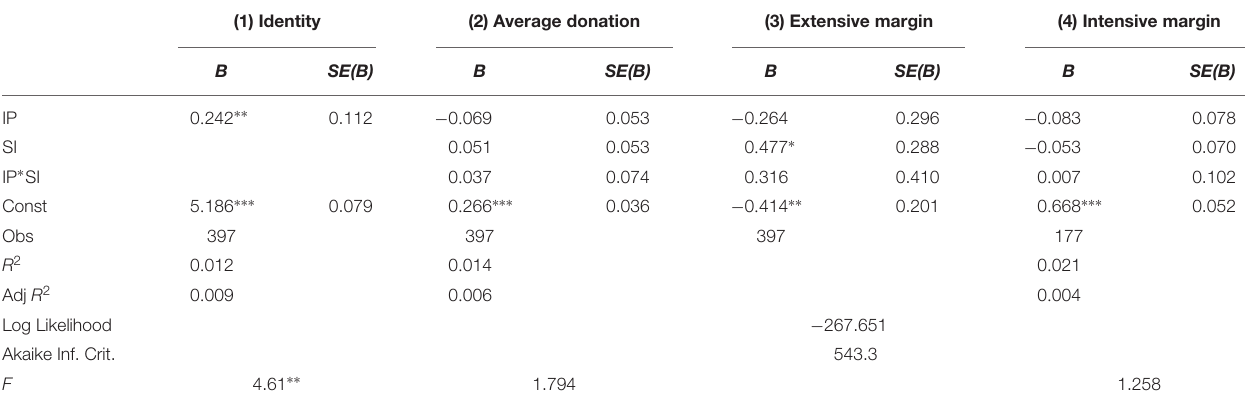
TABLE 2 | Effect of identity priming and social information in Study